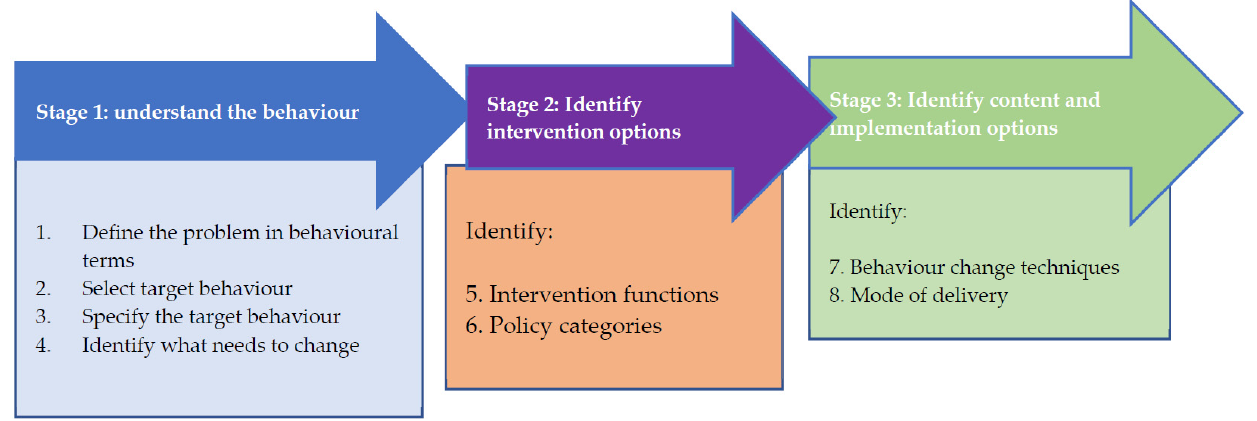
Figure 3. Behaviour change intervention design process (Michie et al.,